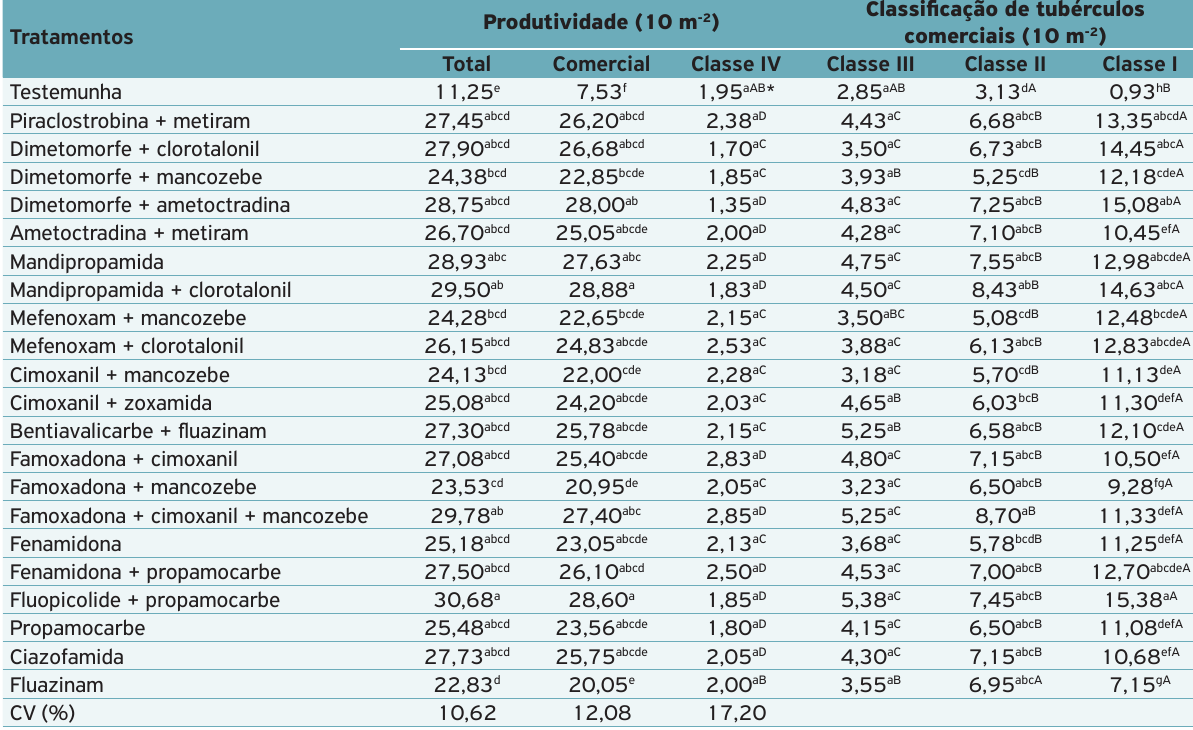
Tabela 2. Produtividade total, comercial e classificação de tubérculos comerciais obtidos de plantas de batata (cultivar